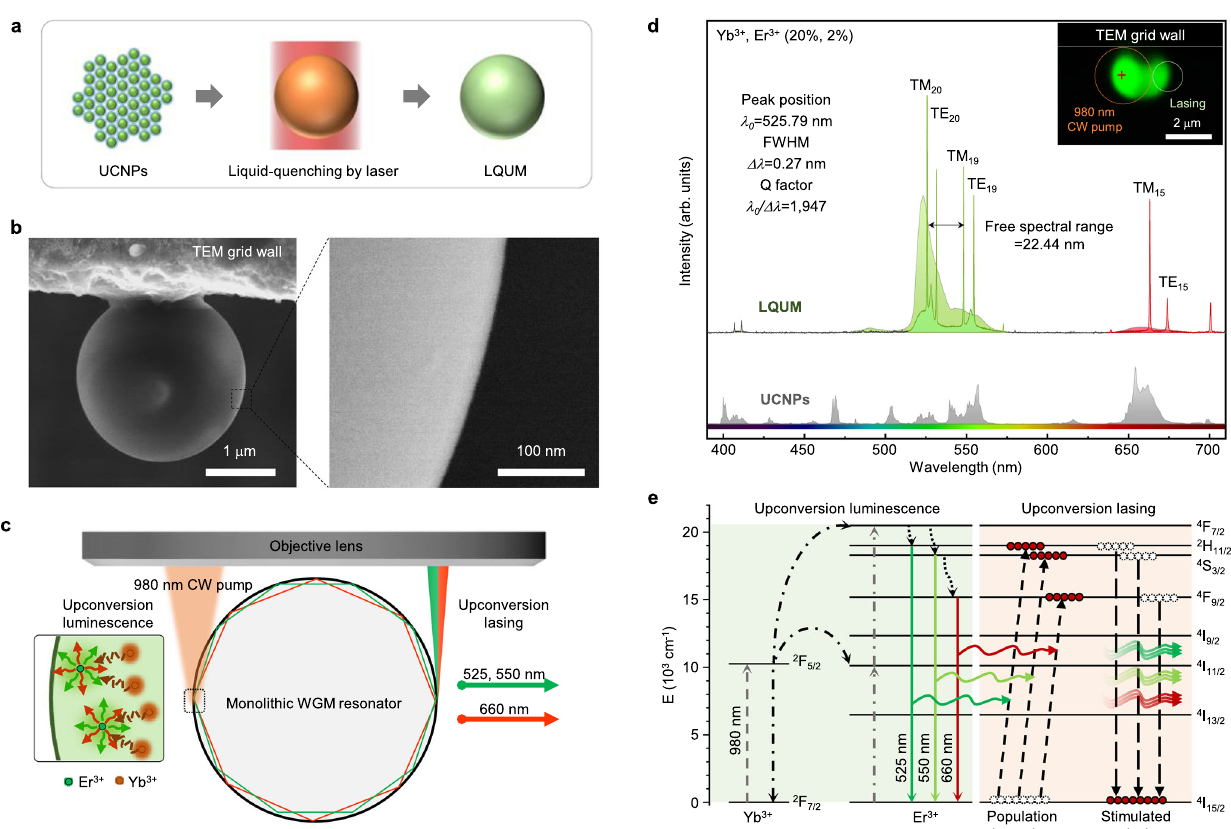
Fig. 1 Continuous-wave upconversion lasing in liquid-quenched upconversion microspheres (LQUM). a Schematic of the fabrication of an LQUM via the liquid quenching of silica-coated β -NaYF 4 :Yb 3 + , Er 3 + (20%, 2%) UCNPs on a TEM grid using a highly focused CW 980-nm laser beam. b SEM images of the LQUM at low and high magni fi cations. Because the direction of light circulation must be aligned perfectly with the circumference of the microsphere, an LQUM dangling on a TEM grid wall was selected for the formation of WGM resonators. c Schematic of upconversion lasing in an LQUM using a free-space beam of a 980-nm continuous-wave pump laser. The LQUM accommodates upconversion lasing through the light circulation along the circumference of the microsphere upon the upconversion luminescence facilitated by energy transfer upconversion of an activator (Er 3 + ) with a sensitizer (Yb 3 + ). d Upconversion luminescence of UCNPs (below) and an LQUM with upconversion lasing (above). The doping concentrations of Yb 3 + and Er 3 + were 20% and 2%, respectively. The color inset shows an optical microscopy image of an illuminated LQUM. e The proposed upconversion lasing pathway supported by energy transfer upconversion in the LQUM. Short-dashed, dot-dashed, colored solid, long-dashed, and dotted lines indicate absorption, energy transfer, spontaneous emission, stimulated emission, and multiphonon relaxation,